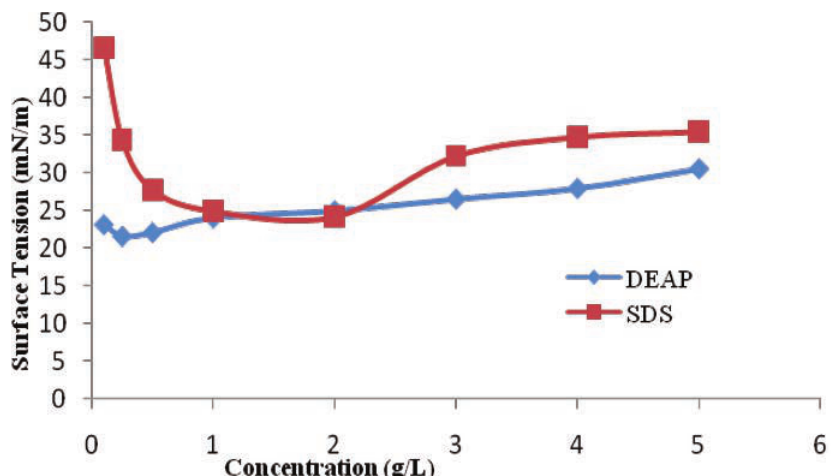
Figure 9. Effect of concentration on surface tension of sodium phosphate-hydroxy ethanolamide and SDS. DEAP = Sodium phosphate-hydroxy ethanolamide.